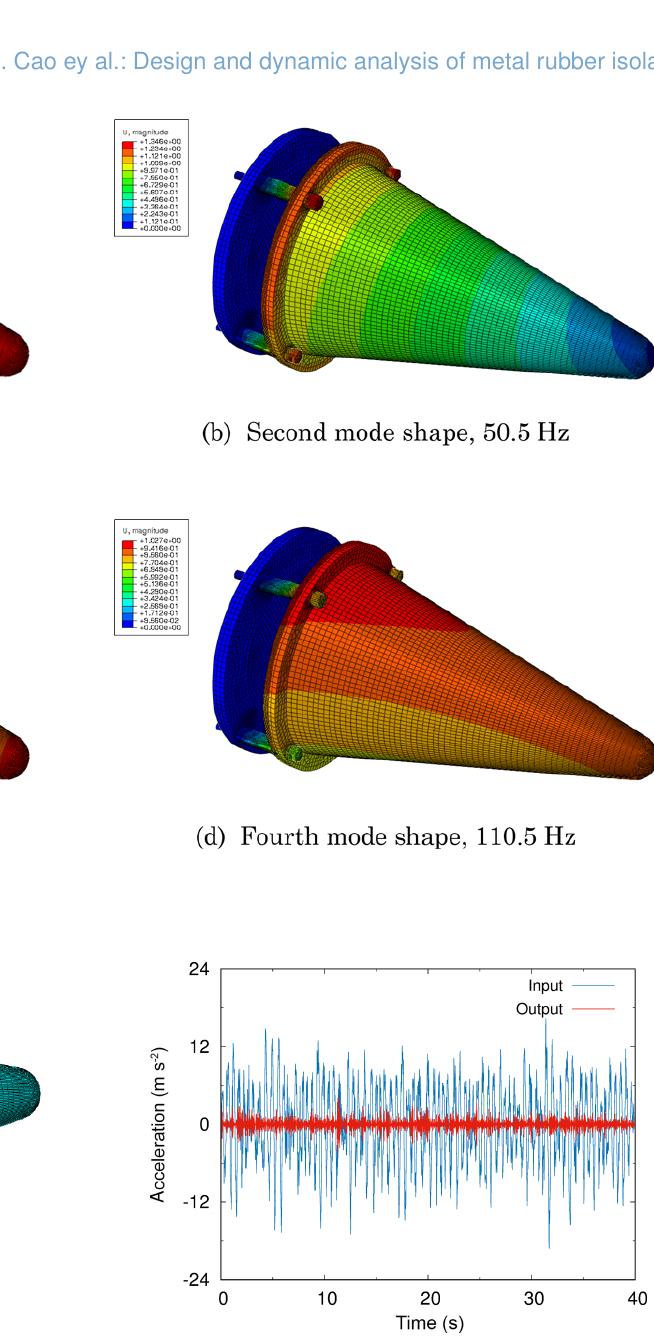
Figure 12. Relative acceleration response of the satellite’s centroid point